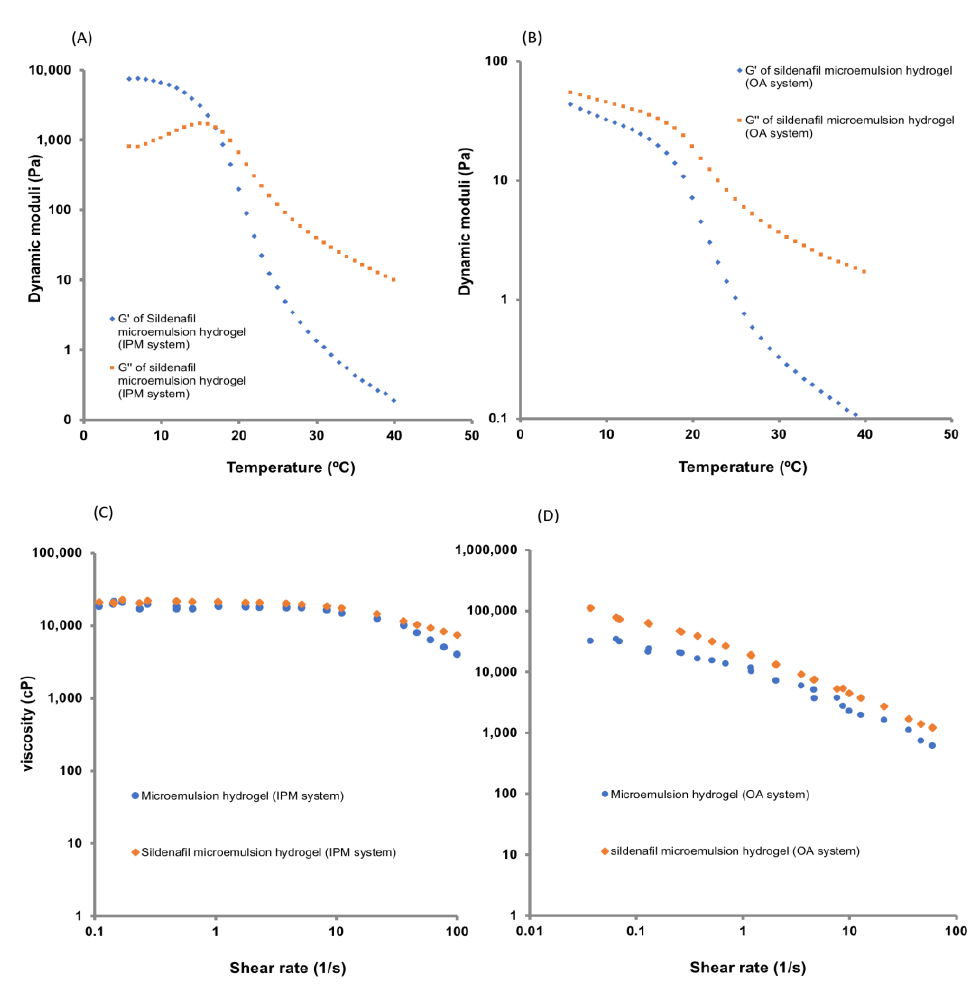
Figure 5. Temperature dependence of the dynamic moduli of isopropyl myristate system ( A ), and oleic acid system ( B ); viscosity curve of the sildenafil microemulsion-loaded hydrogels in different formulations of isopropyl myristate system ( C ), and oleic acid system ( D ).